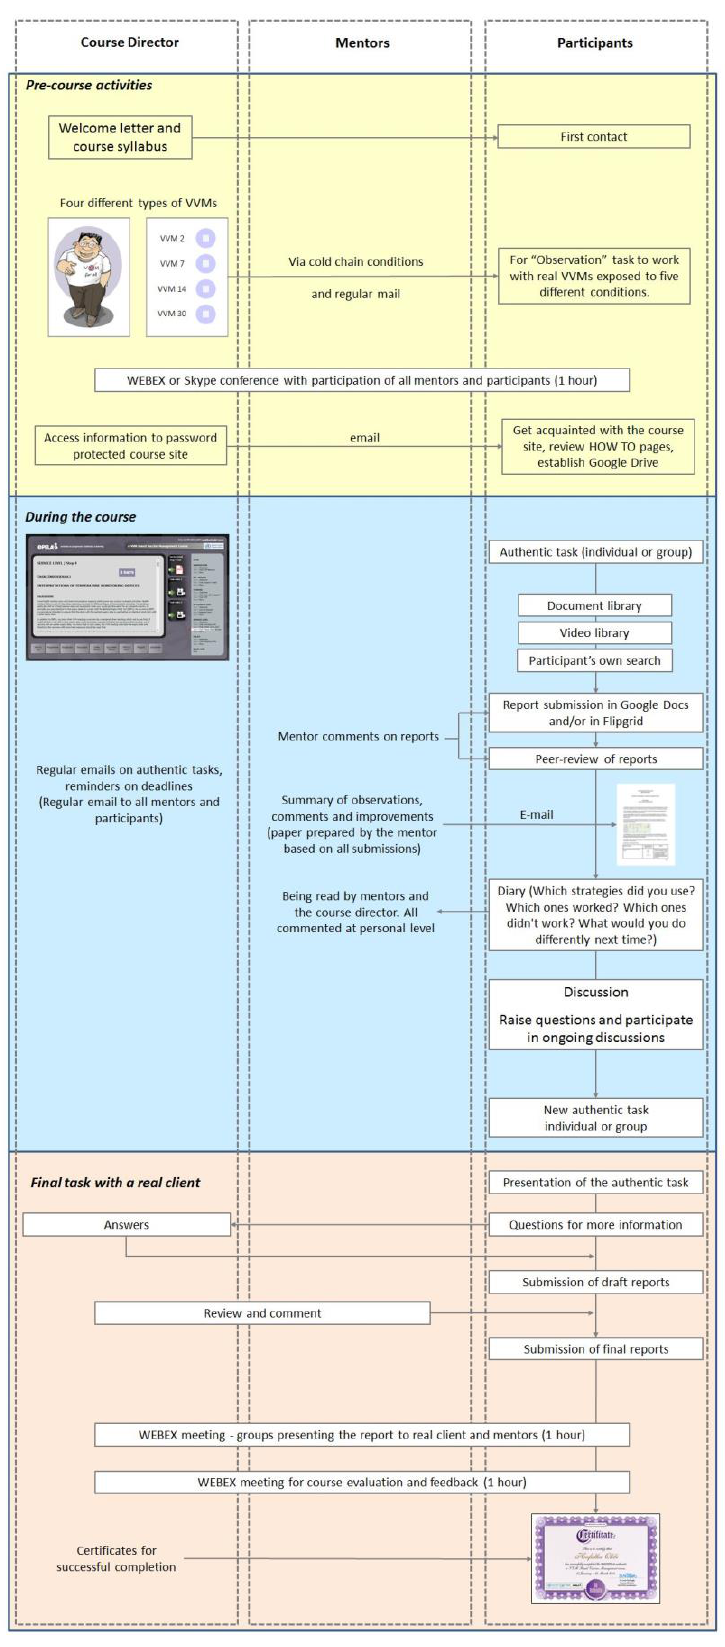
Figure 1. The flow of the eVVM online professional development